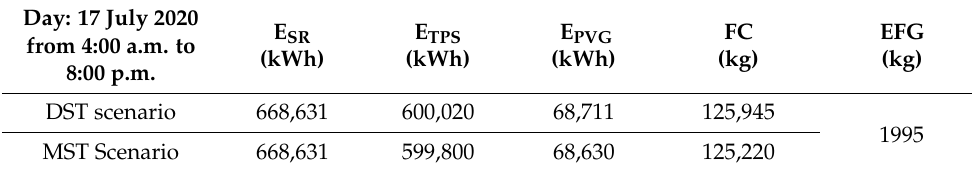
Figure 23. Ideal compensation of PV disturbances. Table 7. CFD derating management additive